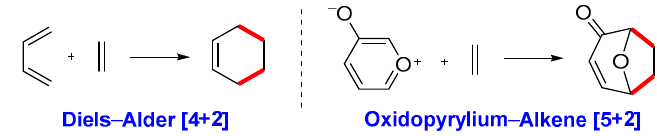
Figure 2. Diels–Alder [4+2] cycloaddition versus oxidopyrylium-alkene [5+2] cycloaddition.